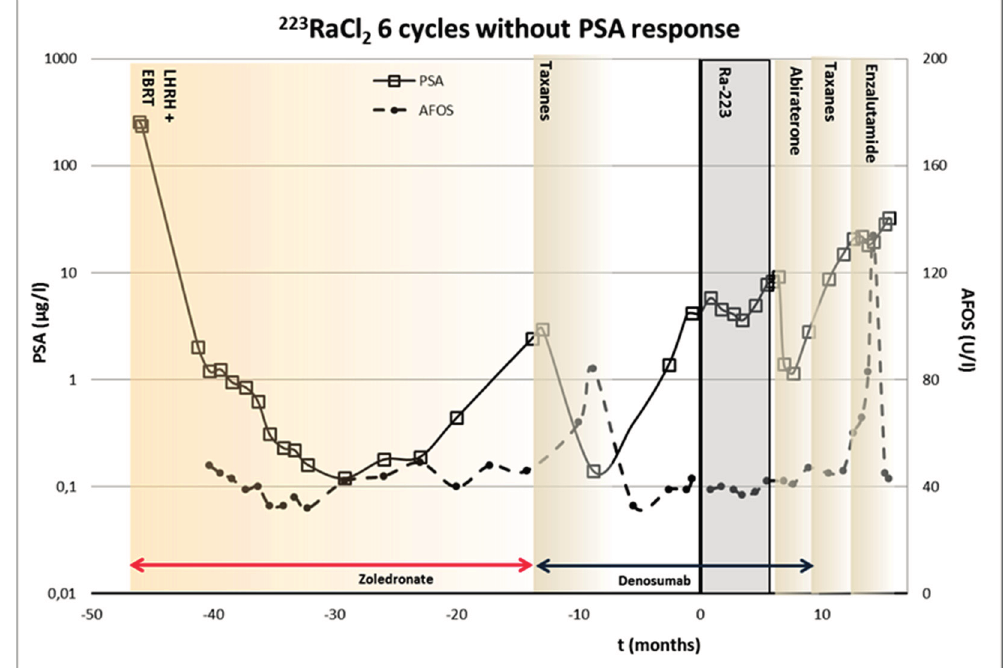
Figure 3. The timing of various treatments of 61-year-old male with prostate cancer (Gleason score 7 (4 + 3)), and 223 RaCl 2 therapeutic dosing schedule. S-PSA and S-AFOS concentrations are presented as well. This patient demonstrated only a change S-PSA velocity due to 223 RaCl 2